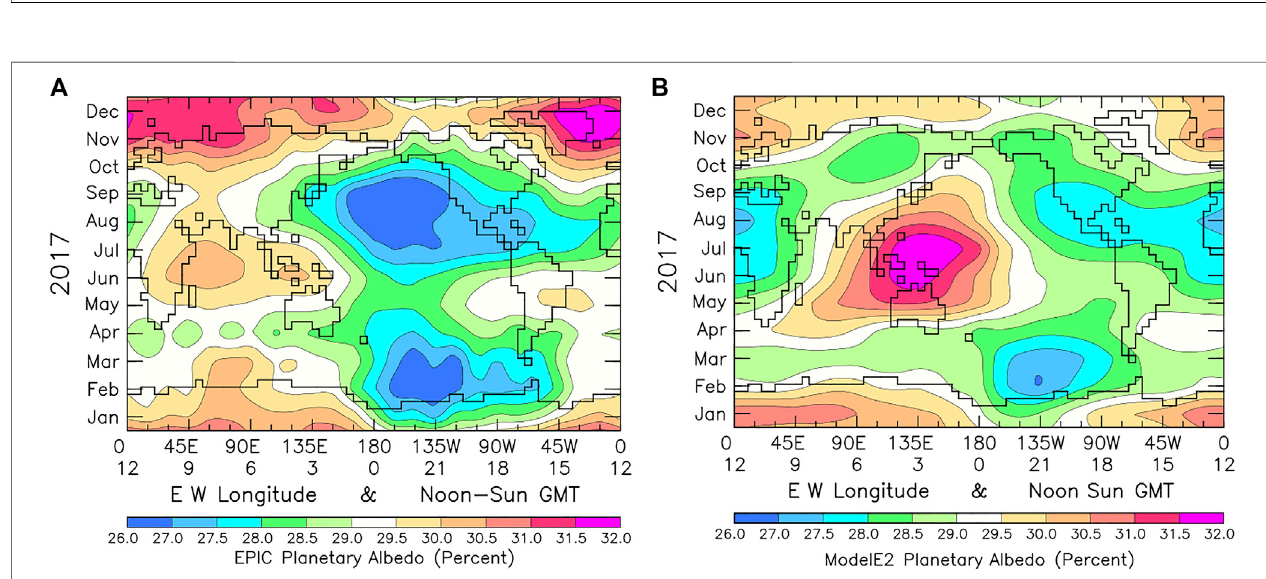
FIGURE10| Hovmöller-style contourplotoftheEPIC (A) andtheGISSModelE2 (B) planetaryalbedofortheyear2017.Inbothcases, theEPICandGCMSW fl ux isnormalizedtotheCERESglobalannual-meanof99.1 Wm – 2(Loebetal.(2018),toyieldaglobalannual-meanof29.1percentfortheplanetaryalbedo.TheY-scalehas timerunningupwardstartingwithJanuaryatthebottomthroughDecemberatthetop.TheX-scaleislongituderunningfrom0 ° Elongitudeattheleftto0 ° Wlongitudeat theright.GMTreferencesthelocationofhigh-noonSun.Theworldmapisincluded forlongitudinalreference.ThedatafortheEPIC (A) andGISSModelE2 (B) year 2017 planetary albedo are reproduced here from Carlson et al. (2021) modeling results.